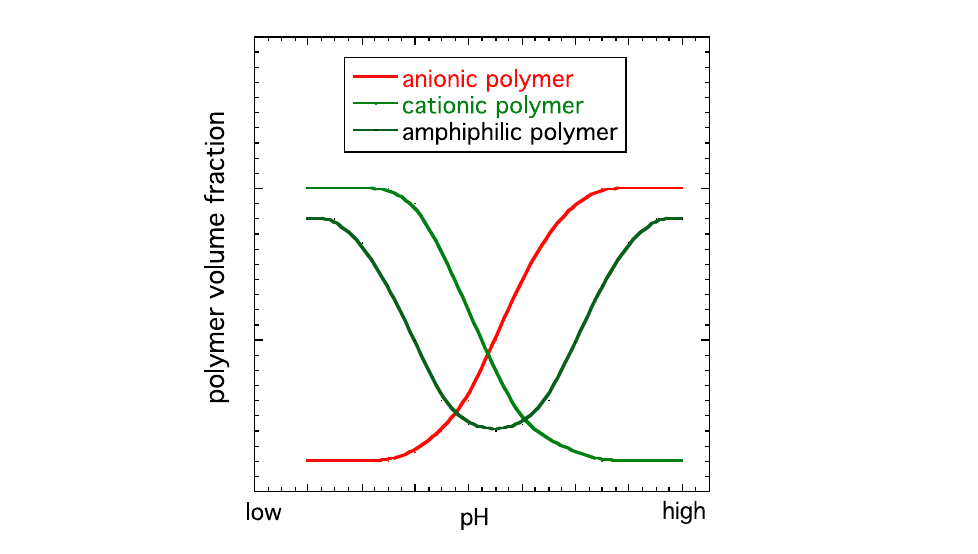
Scheme 1. Schematic representation of the variation in the polymer volume fraction as a function of the pH in different types of polyelectrolyte gels. Anionic gels swell in basic solutions (high pH), and cationic gels swell in acidic solutions (low pH). Amphiphilic gels swell in both low- and high-pH solutions.